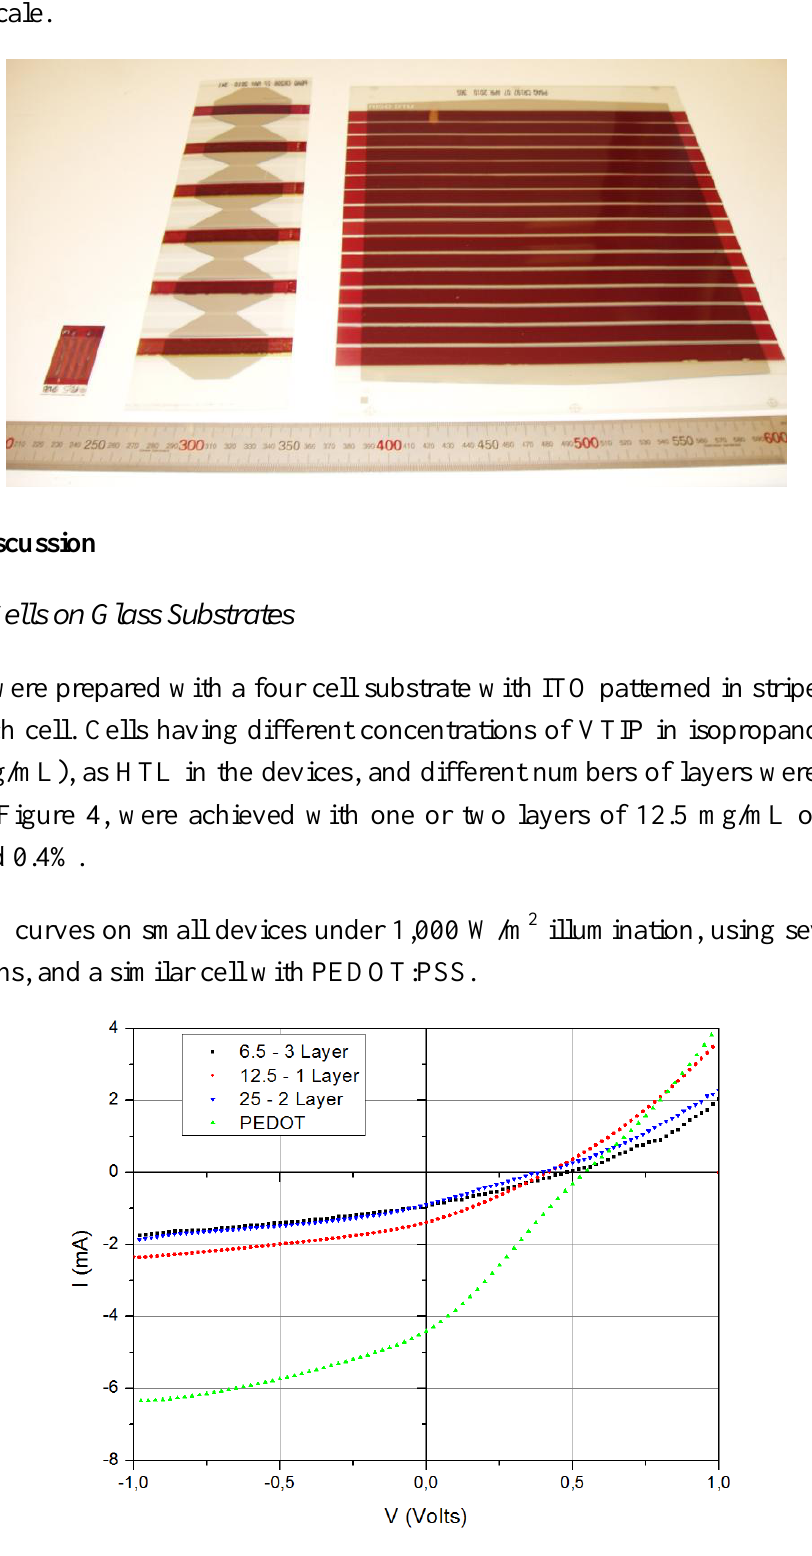
Figure 3. Image of a typical glass cell, gradient cell, and 16 cell module (from left to right) with a mm scale.